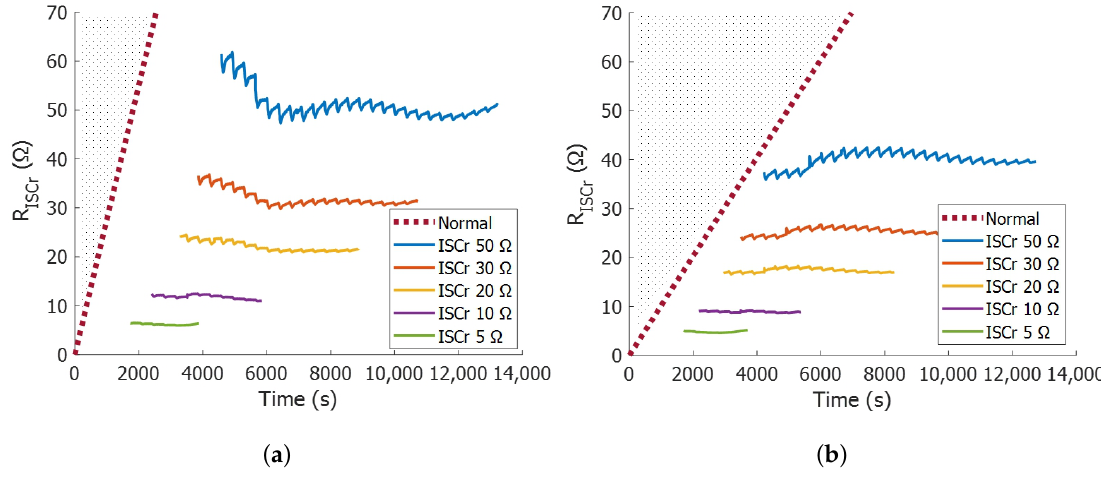
Figure 9. Reliable maximum (cid:98) R ISCr , n in simulation and experiment with normal battery pack and DST current profile: ( a ) simulation and ( b )